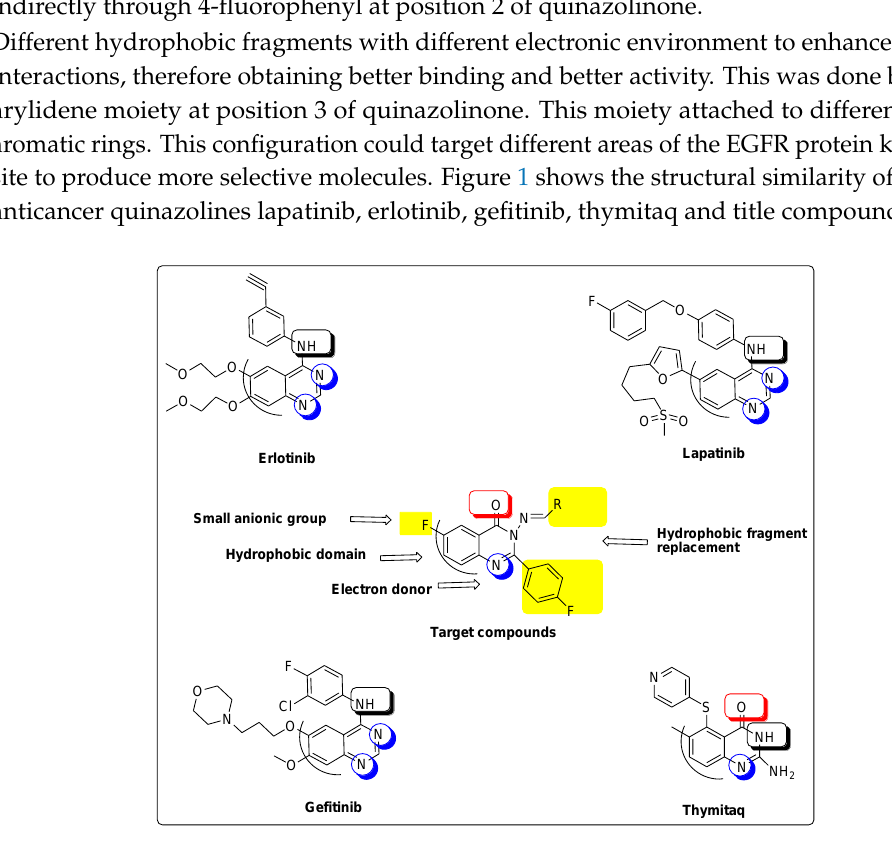
Figure 1. Structural similarities of the reference anticancer quinazolines lapatinib, erlotinib, gefitinib, thymitaq and our designed compounds.